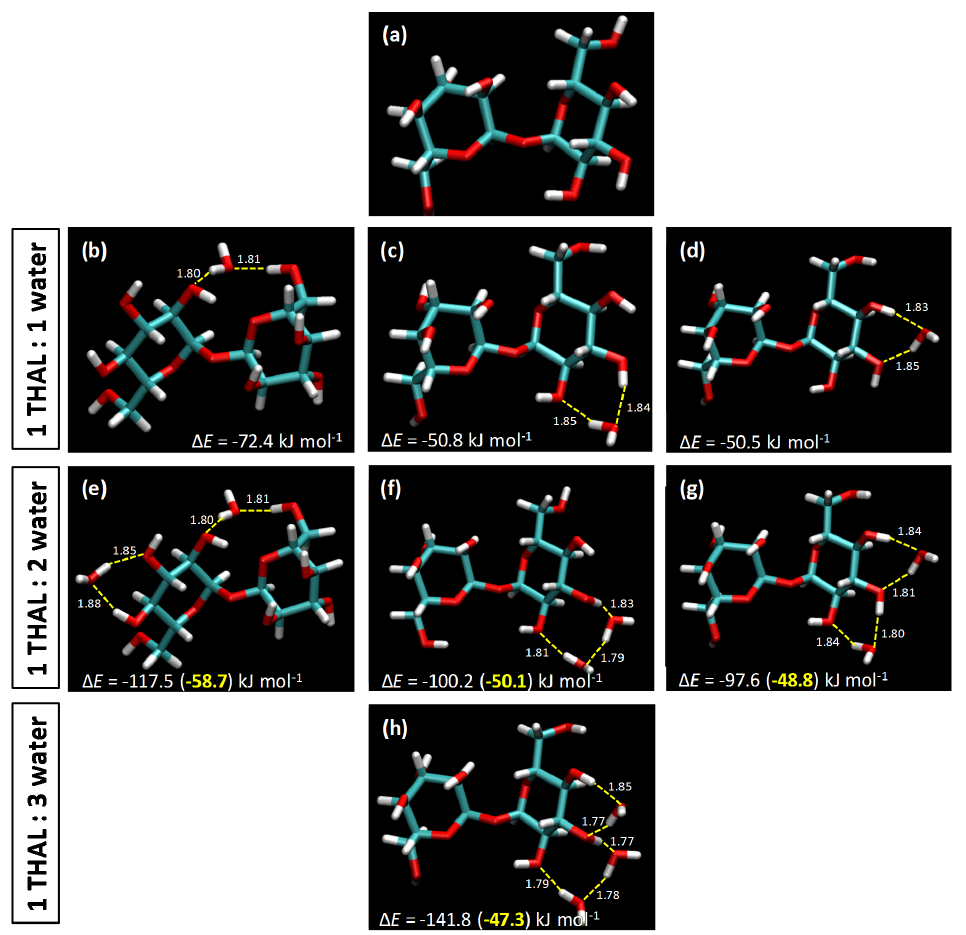
Figure 2. Structure of ( a ) THAL and ( b – h ) 1 THAL + i water clusters ( i = 1 to 3) optimized from DFT calculations. Dashed yellow lines show relevant THAL-water hydrogen bonds, with interaction distance in Å. Interaction energies, Δ E , are also reported.